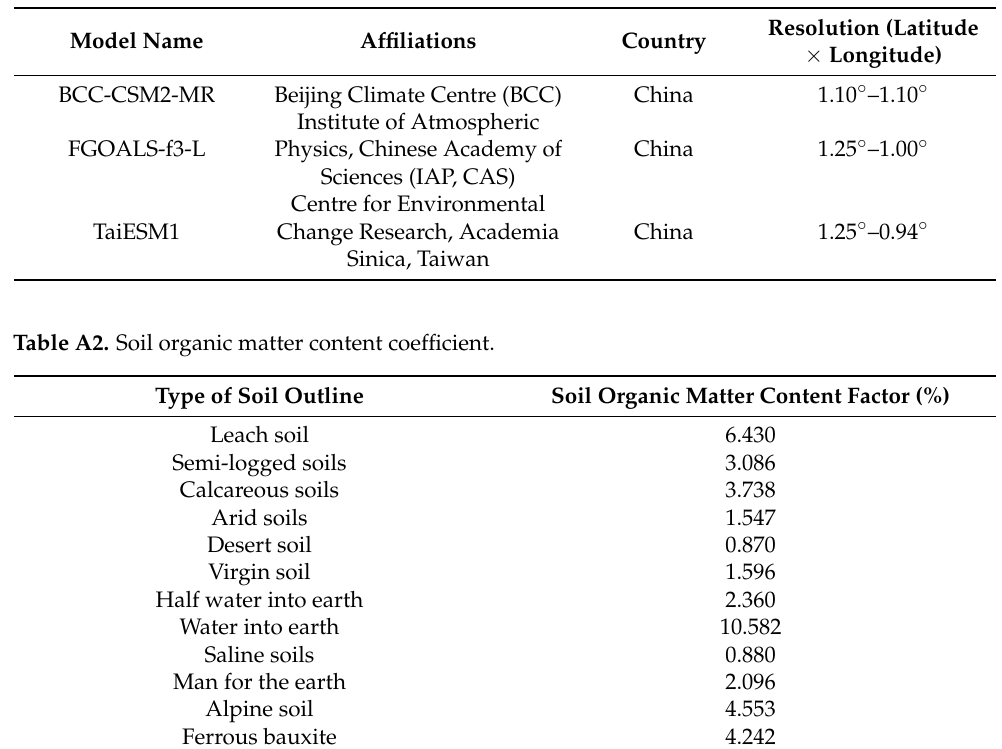
Table A1. CMIP6 model data resource.